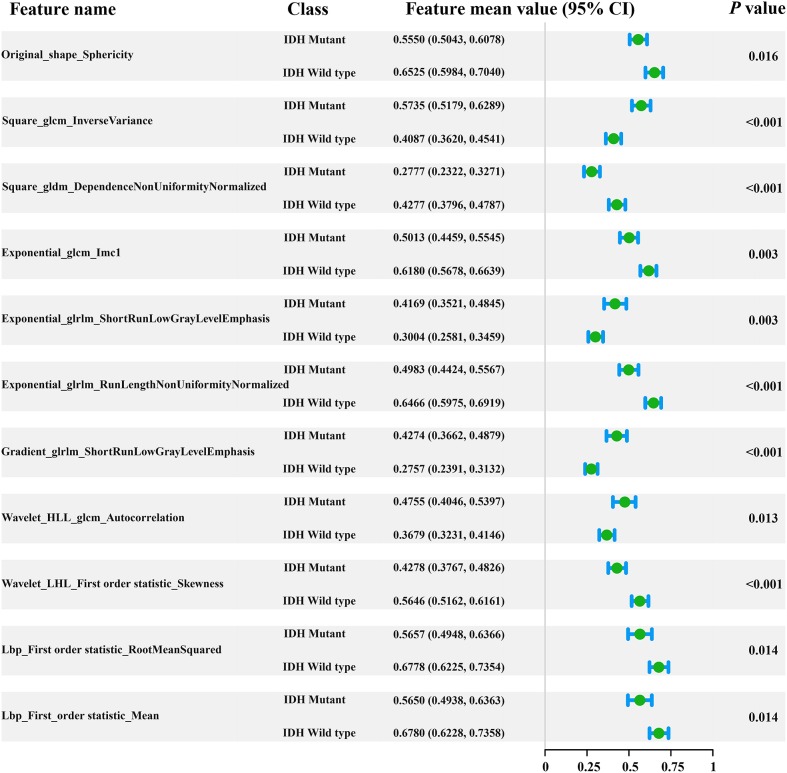
Forest plot of the 11 selected radiomic features. All features yielded significant differences in IDH mutant and IDH wild-type patients (independent t-test, p < 0.05).